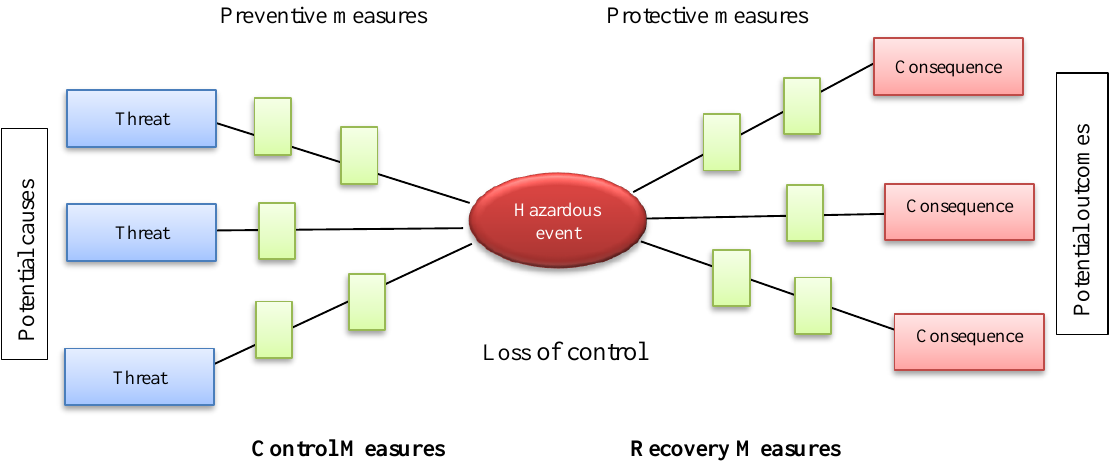
Figure 1. Implementation of Bow-Tie structure [9].